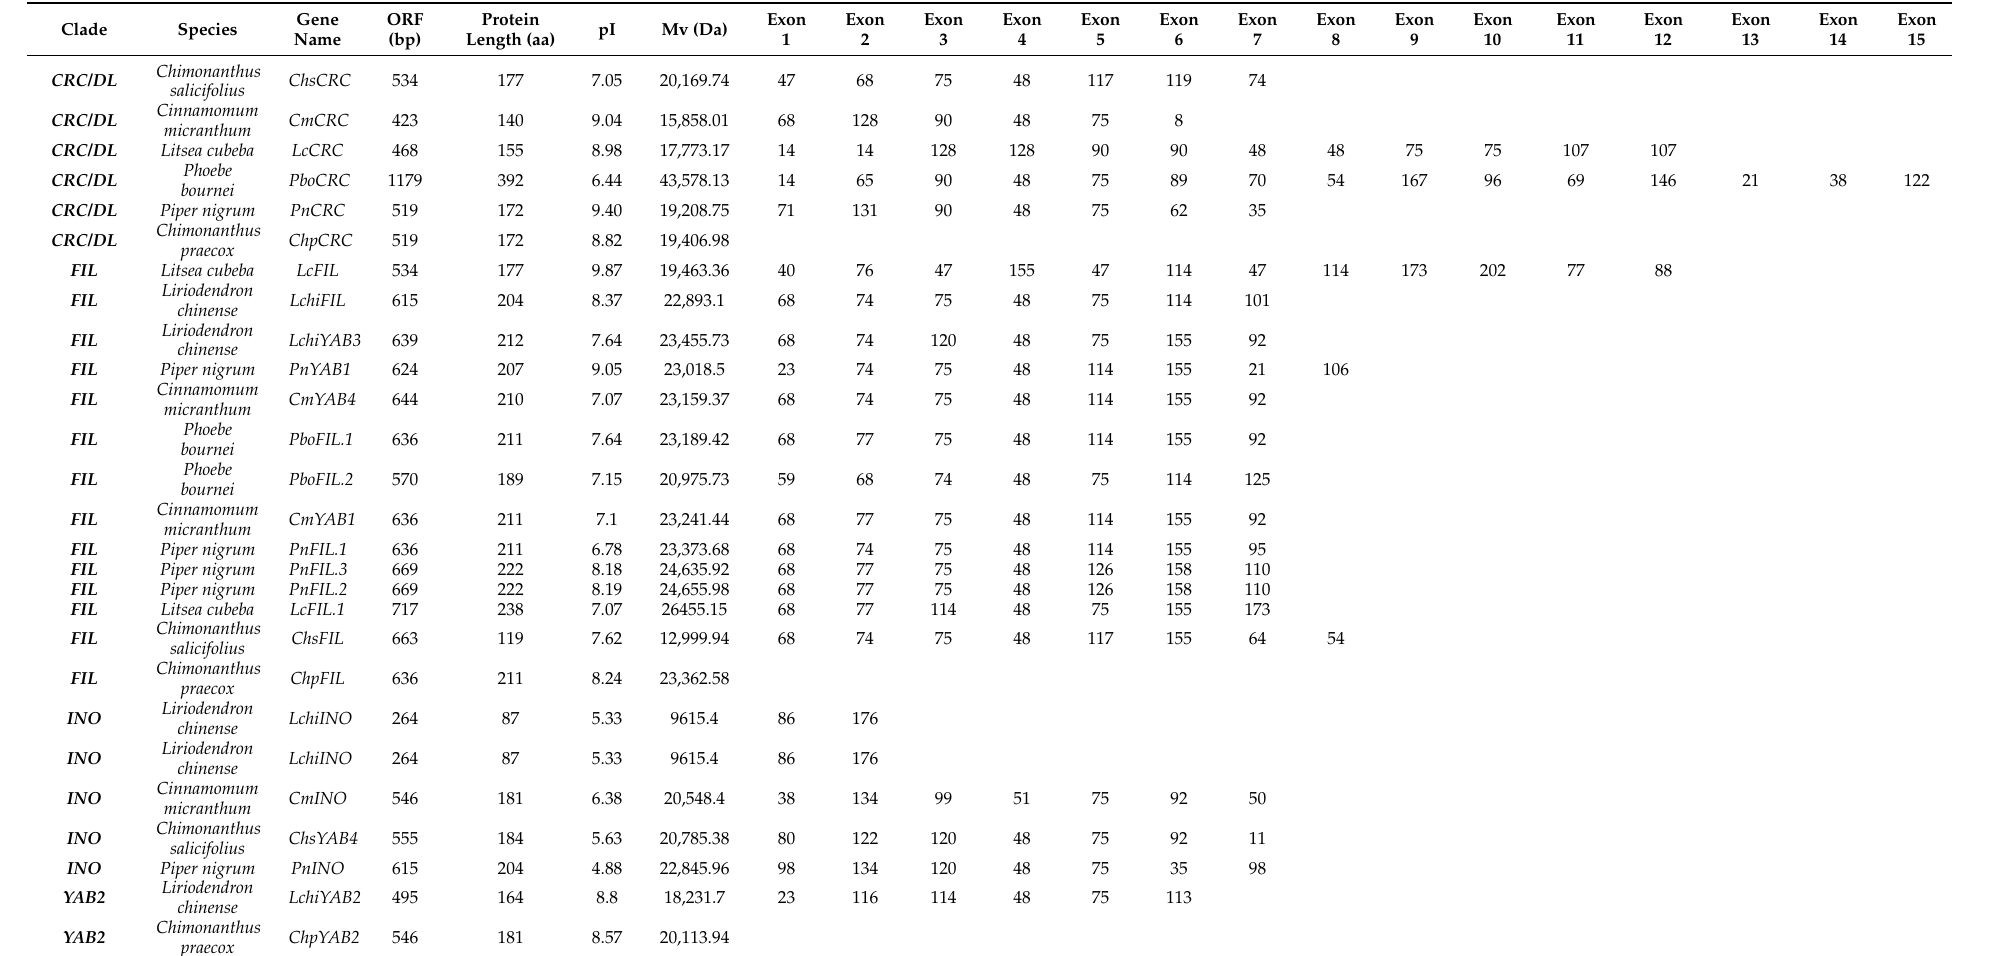
Table 2. The gene structures and physical properties of YABBY